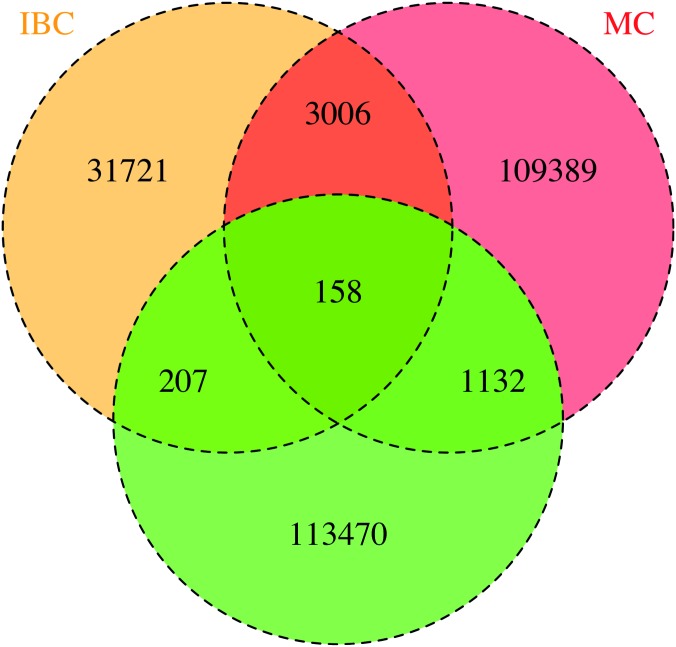
Overlap SNPs after imputation on the different platforms and the combined imputation.